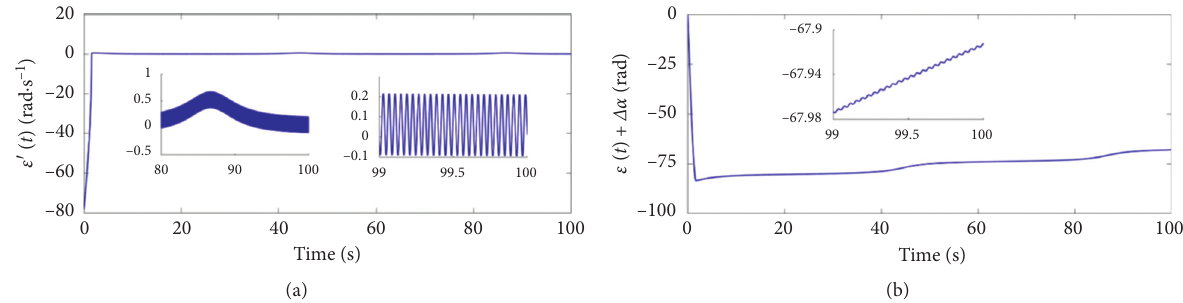
Figure 4: Simulation curve when ω � 24.9 π and A � 0.002m. (a) ε ′ ( t ) graph. (b) ε ( t ) + Δ α